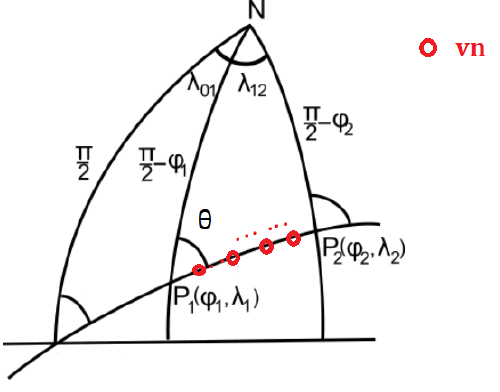
Figure 10. Great circle path between GW ( P 1 ) and WSN ( P 2 ) adapted from